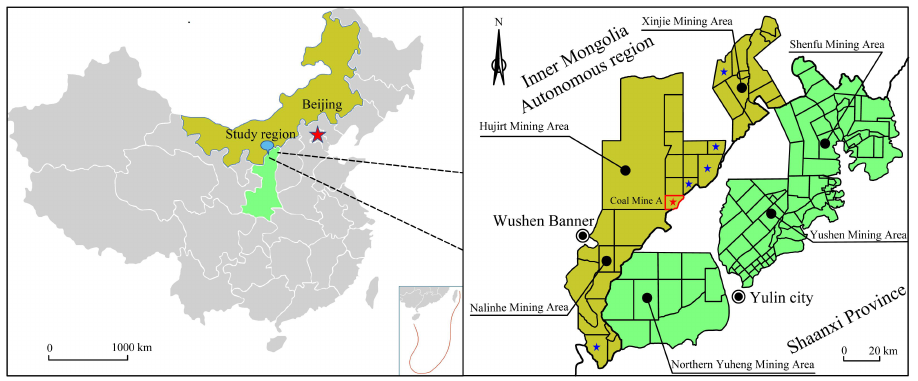
Figure 1. Location of the study region.